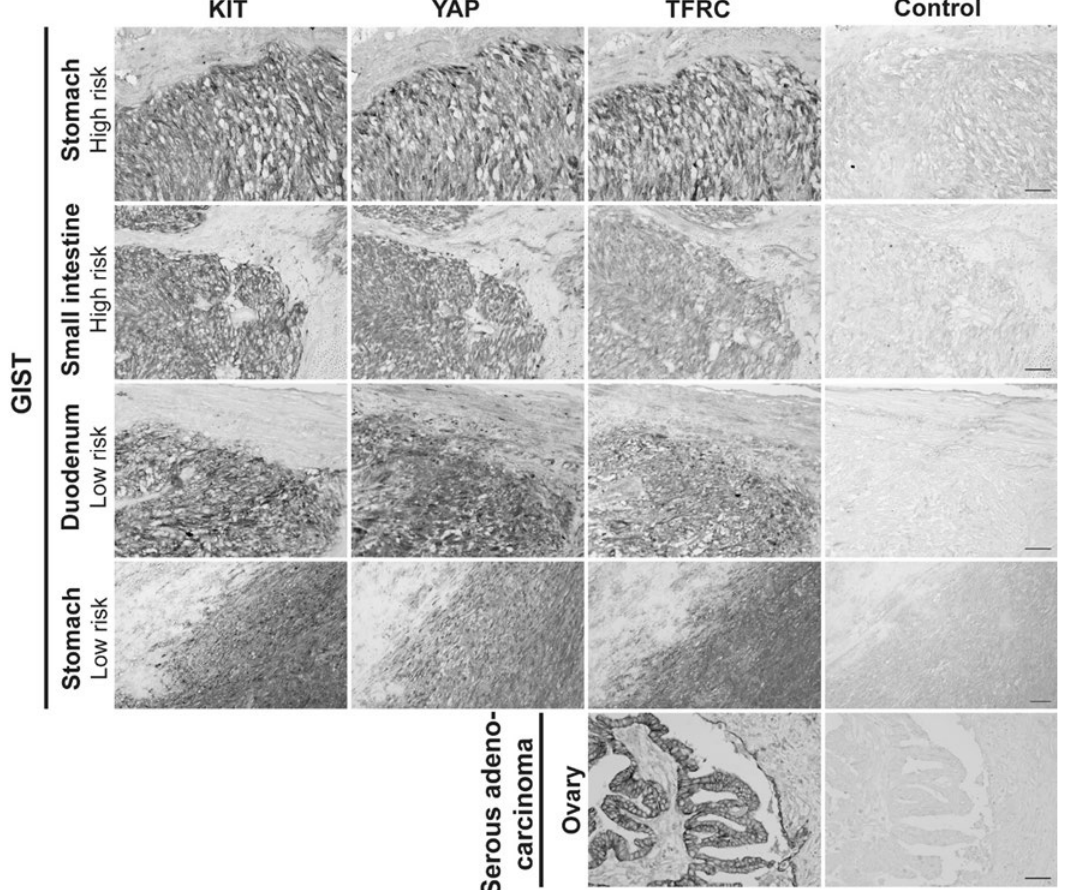
Figure 8. TFRC expression in human primary GISTs. Immunohistochemistry for KIT-ir, YAP-ir, and TFRC-ir in four different human primary GISTs located in the stomach and small intestine, with high or low risk of malignity. Ovarian serous adenocarcinoma was used as a positive control for TFRC-ir. Scale bar = 50 μm.